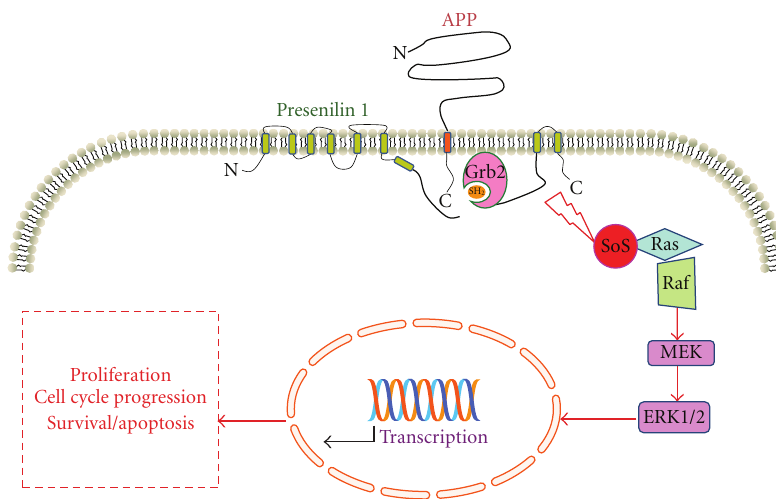
Figure 2: Schematic representation of the intracellular pathway by which A β PP and PS1 control the activation of the MAPK/ERK1/2 cascade and their final biological e ff ects. In the figure is specified the interaction between APP intracellular domain and PS1 C-terminus, with the adaptor protein Grb2. Grb2 can bind simultaneously to APP and PS1 (as measured in FRET experiments) leading to the MAPK ERK1/2 cascade activation. In AD an aberrant activation of ERK1/2 induced by APP and/or PS1 can determine the tentative activation of the cell cycle that, in postmitotic neurons, may induce cells to undergo apoptosis.